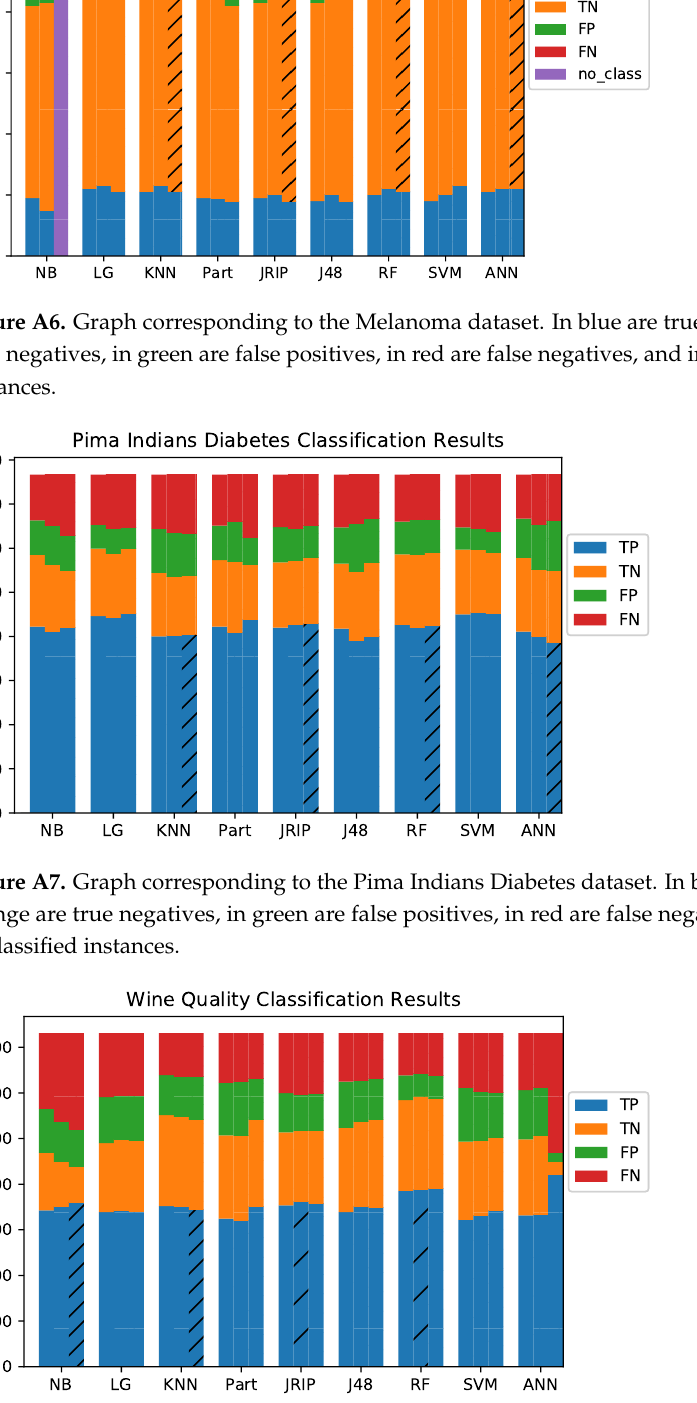
Figure A8. Graph corresponding to the Wine Quality dataset. In blue are true positives, in orange are true negatives, in green are false positives, in red are false negatives, and in purple are unclassified